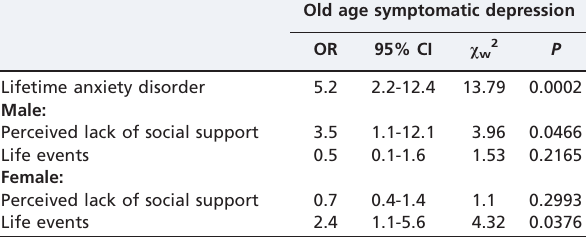
Table 2 - Determinants of ‘‘old age symptomatic depres- sion’’: final model of stepwise logistic regression (adjust- ed odds ratio and 95% CI). The Sa˜o Paulo Epidemiologic Catchment Area Study; N of subjects 60 years or older =